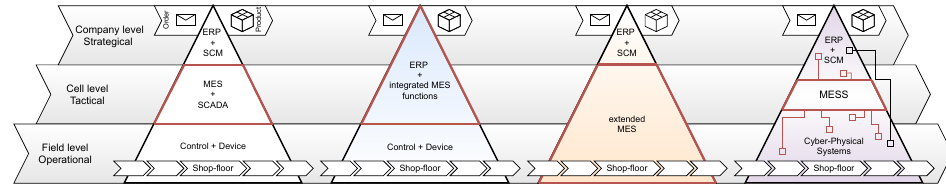
Figure 1. Different functional positioning of Manufacturing Execution System within a